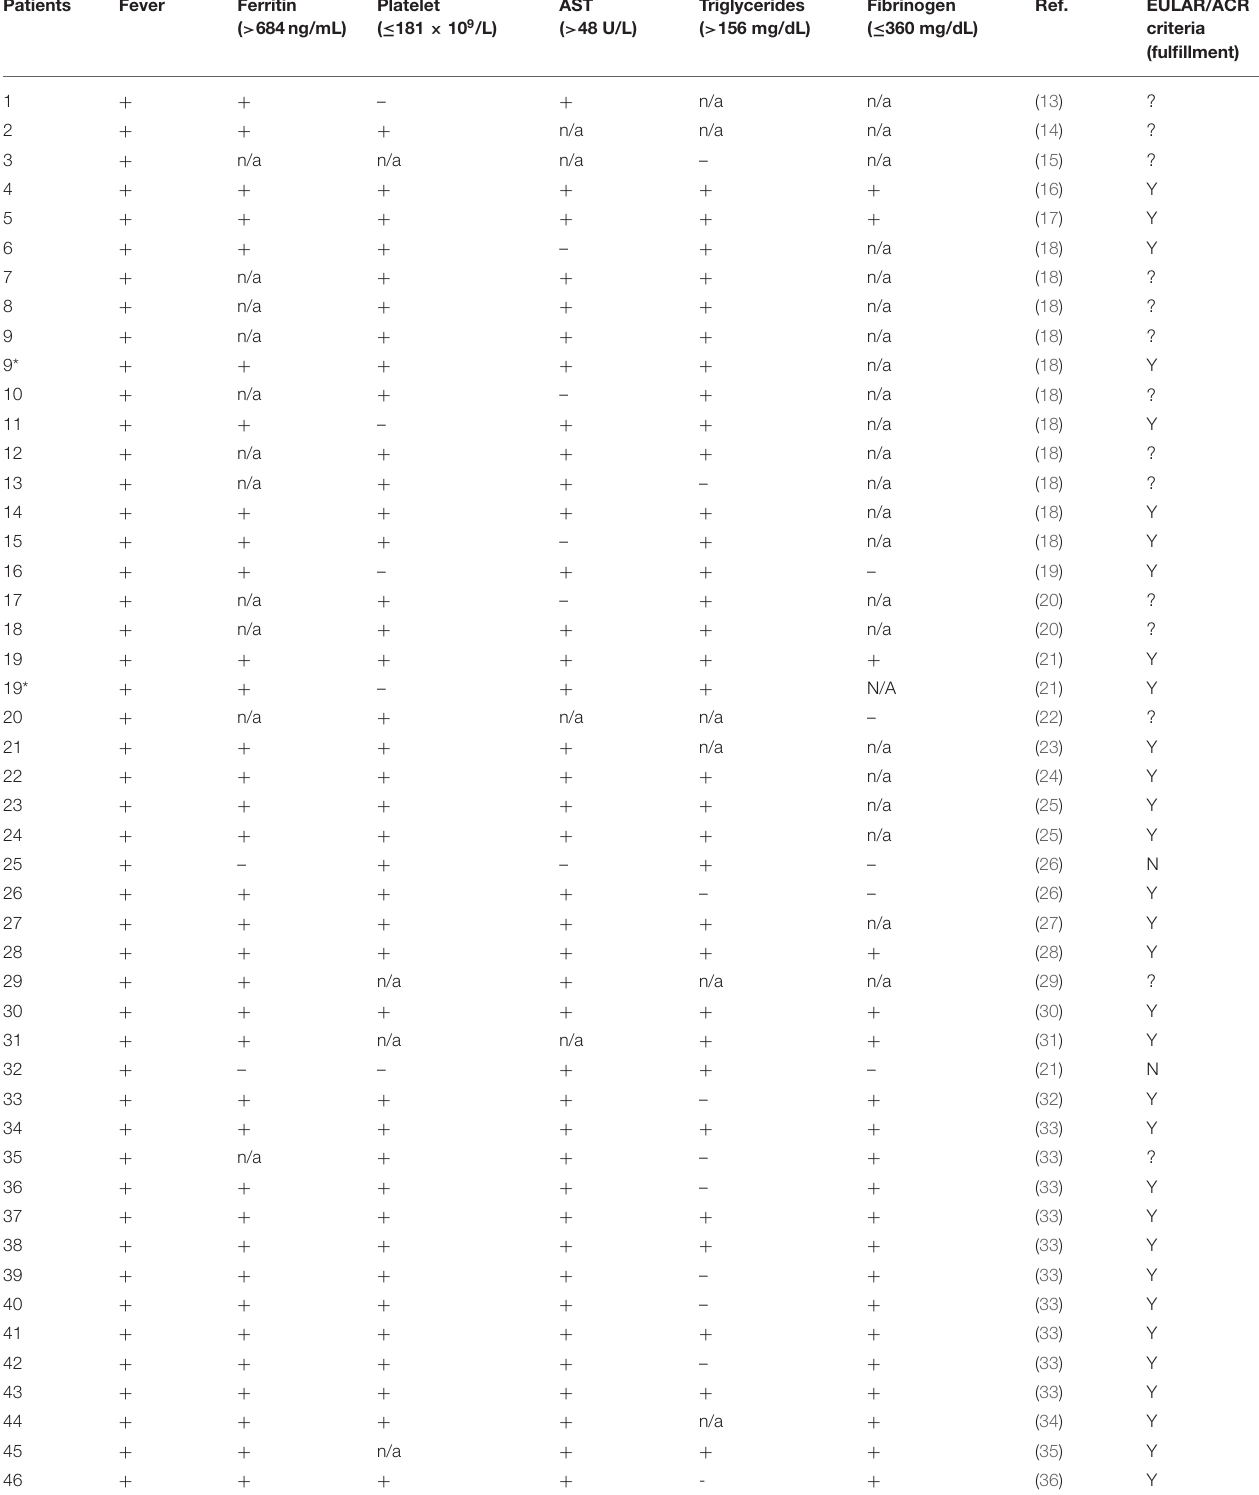
TABLE 3 | Fulfillment of the sJIA EULAR/ACR 2016 diagnostic criteria for MAS in reported cases of pSLE with MAS. Patients